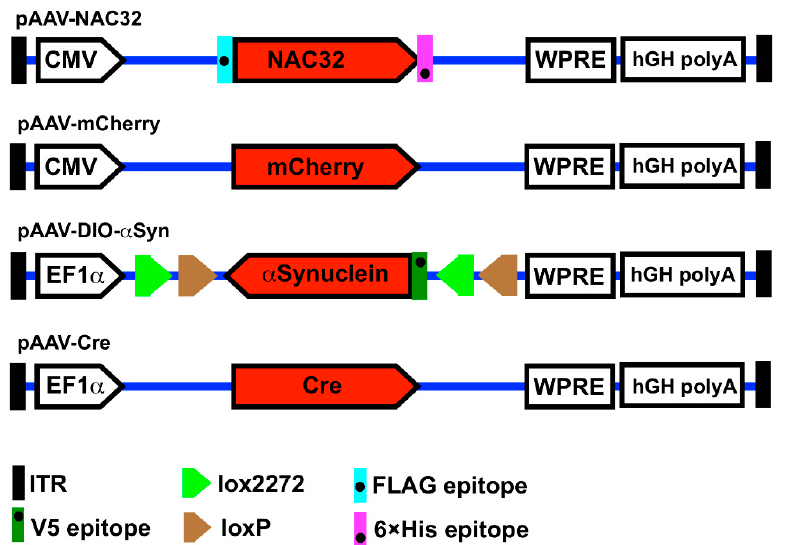
Figure 2. Illustration of adeno-associated virus vector plasmids. The pAAV-NAC32 plasmid encodes an α Syn-specific single-chain intrabody tagged with a FLAG epitope at the N-terminal and a 6 × His epitope at the C-terminal. The pAAV-mCherry plasmid encodes a red fluorescence protein mCherry. The gene expression of these two constructs is driven by a promoter derived from cytomegalovirus. The pAAV-DIO- α Syn plasmid carries a double floxed inverted open reading frame (DIO) of the α Syn gene (tagged with a V5 epitope at the N-terminal) driven by the EF1-a promoter. The pAAV-Cre plasmid encodes a codon-improved Cre recombinase driven by the EF1-a promoter. The expression cassettes of these four constructs are flanked by the left- and right-inverted terminal repeat sequences (ITR) of serotype-2 adeno-associated virus. CMV, cytomegalovirus promoter; EF1a, elongation factor 1a promoter; lox2272, loxP, target sequences for the Cre recombinase; WPRE, woodchuck hepatitis B virus post-transcriptional regulatory element; hGH polyA, polyadenylation signal sequence of human growth hormone.